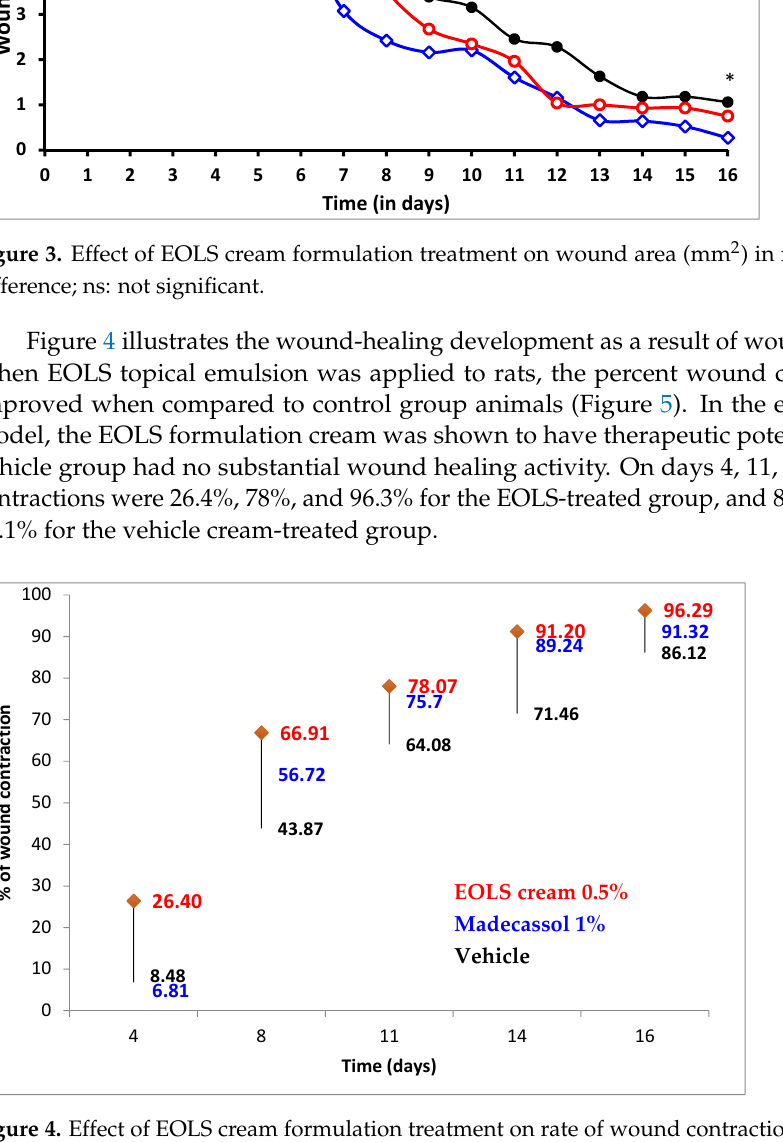
Figure 5. Photographs of rats (dorsal region) showing various phases of wound healing. ( A ): EOLS cream formulation (0.5% w / w ); ( B ): positive control (Madecassol ® cream 1%); ( C ): vehicle. 3.2.2. Histological Examination Histopathology was performed on skin samples. Histological analyses supported the findings of the excision experimental study. Representative photomicrographs (Fig- ure 6) stained with H&E were also used to demonstrate the wound healing phase. Among the experimental classes, different stages of wound healing processes were studied. Among the experimental groups, wound healing stages (inflammation, prolif- eration, and remodeling) were observed and documented (Table 4). Wound healing processes were delayed in the negative control group, while quicker remodeling was found in the test groups in different degrees.